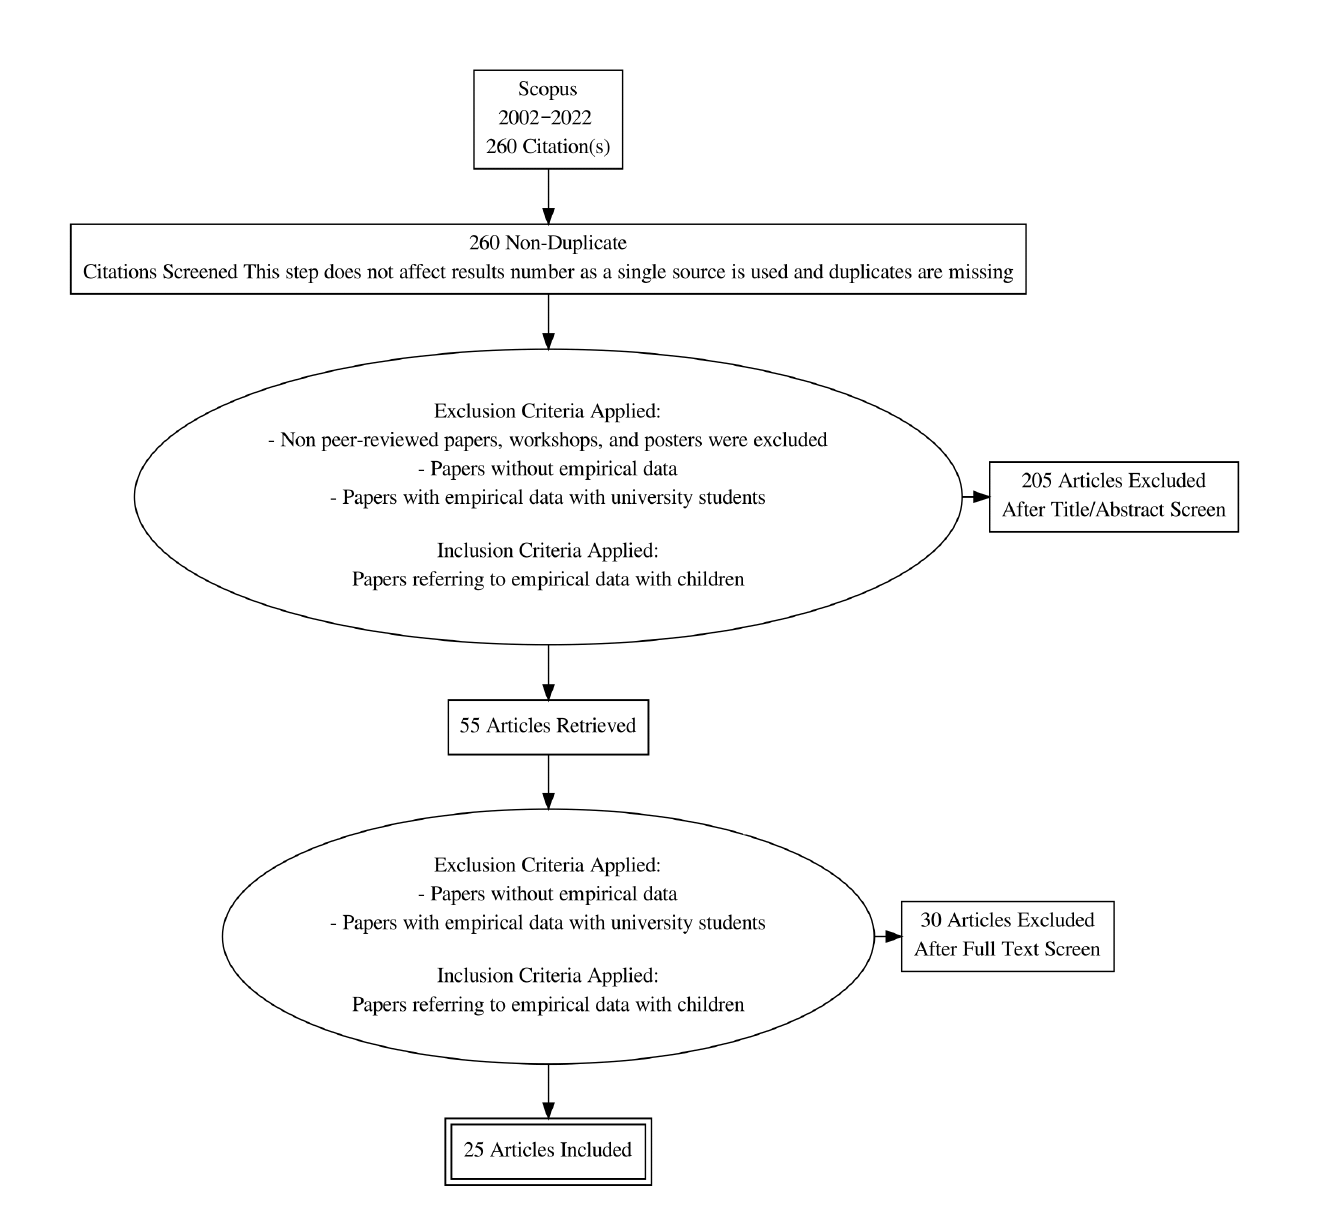
Figure 1. PRISMA chart describing the workflow on the basis of this literature